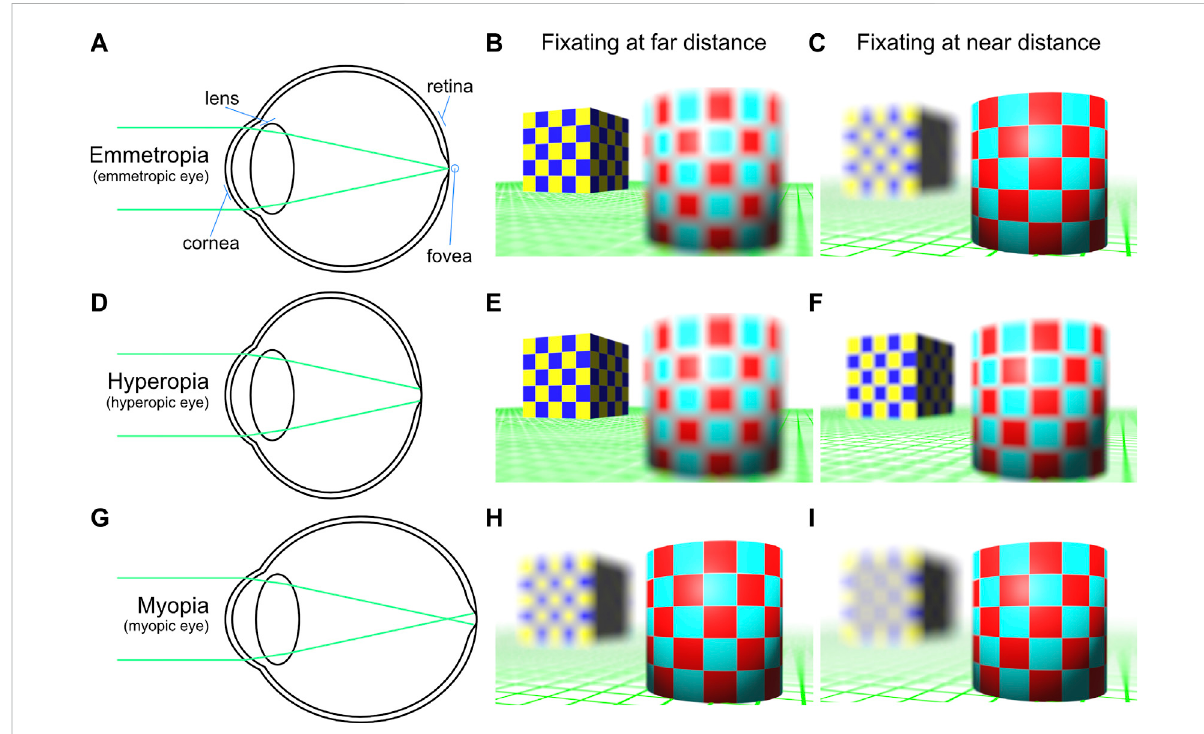
FIGURE 1 Refractive errors. An emmetropic eye has no refractive error if the optical power of the cornea is matched to the length of the eye (A) . Light re fl ected from a far away object is focused on the fovea, forming a sharp image (B) , however, nearer objects are blurred due to the limited depth of fi eld of the eye. By adjusting the lens, near objects can be brought into focus (by accommodation), although distant objects become unfocused (C) . An emmetrope can effortlessly switch between fi xating on objects at different distances while keeping the object of fi xation sharp. A hyperopic eye is too short for the optical power of the eye (D) . Far away objects can be kept in focus by accommodation (E) , but this leaves less lens power available for focusing at near objects, which remain blurred (F) . A hyperope is less able to switch between fi xating on objects at different distances, having dif fi culty maintaining focus on near objects, especially for longer durations. A myopic eye is too long for the optical power of the eye (G) . Far away objects always appear blurred (H) while near objects are focusable (I)